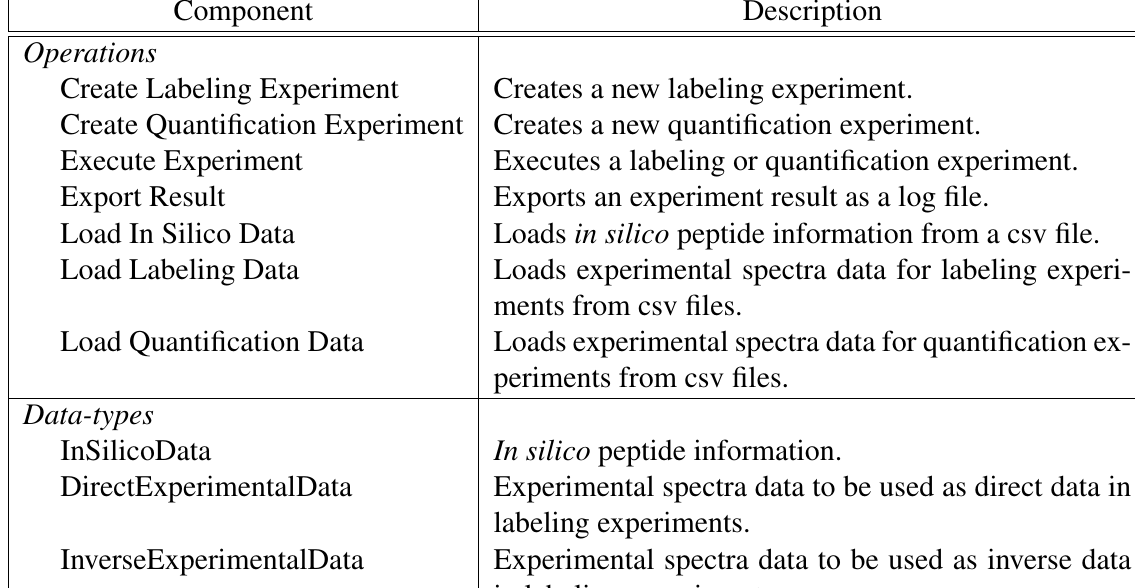
Table 1: AIBench components of the DPD